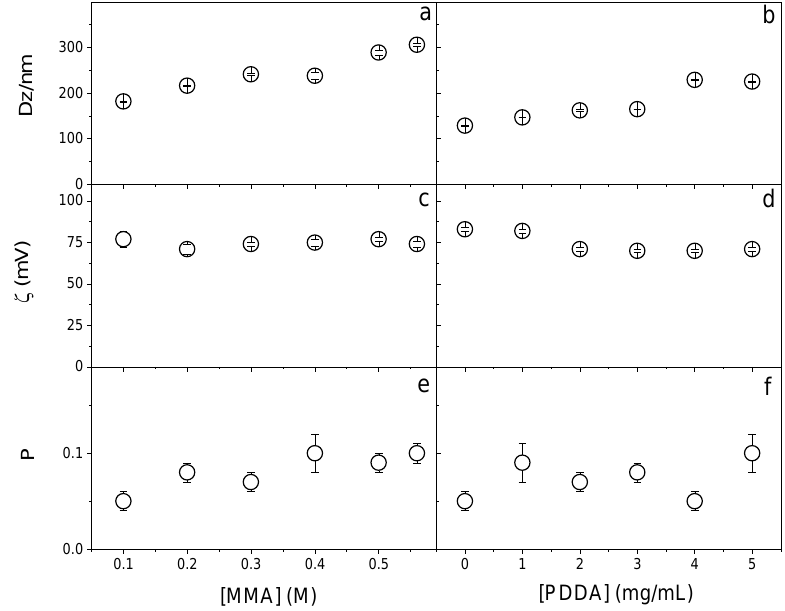
Figure 1. Effect of MMA or PDDA concentrations on ( a , b ) hydrodynamic diameter (Dz), ( c , d ) zeta-potential ( ζ ), and ( e , f ) polydispersity (P). All dispersions were synthesized by the emulsion polymerization method using 1.5 mM of DODAB and 0.0036 g of AIBN initiator. To evaluate the effect of MMA concentration, the synthesis was performed at 5 mg/mL of PDDA and to evaluate the effect of PDDA, 0.2 M MMA was used. Data points are mean values ± the mean standard de-